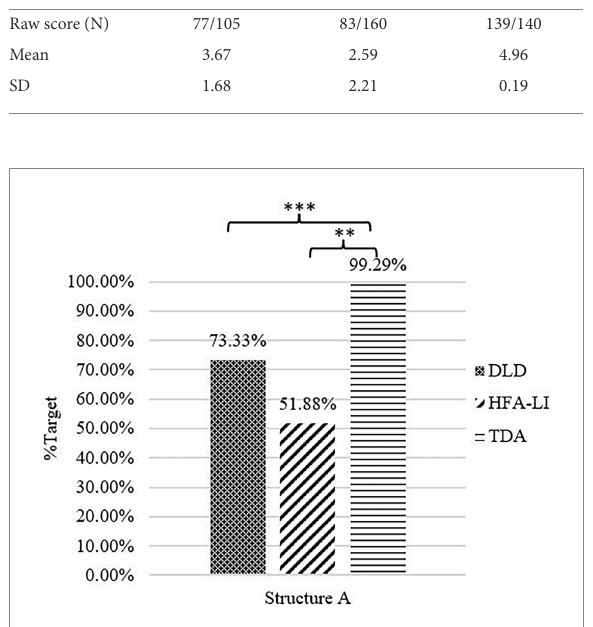
FIGURE 3 Percentage of target responses in Structure A. ** = significance ( p < 0.01), *** = significance ( p < 0.001).